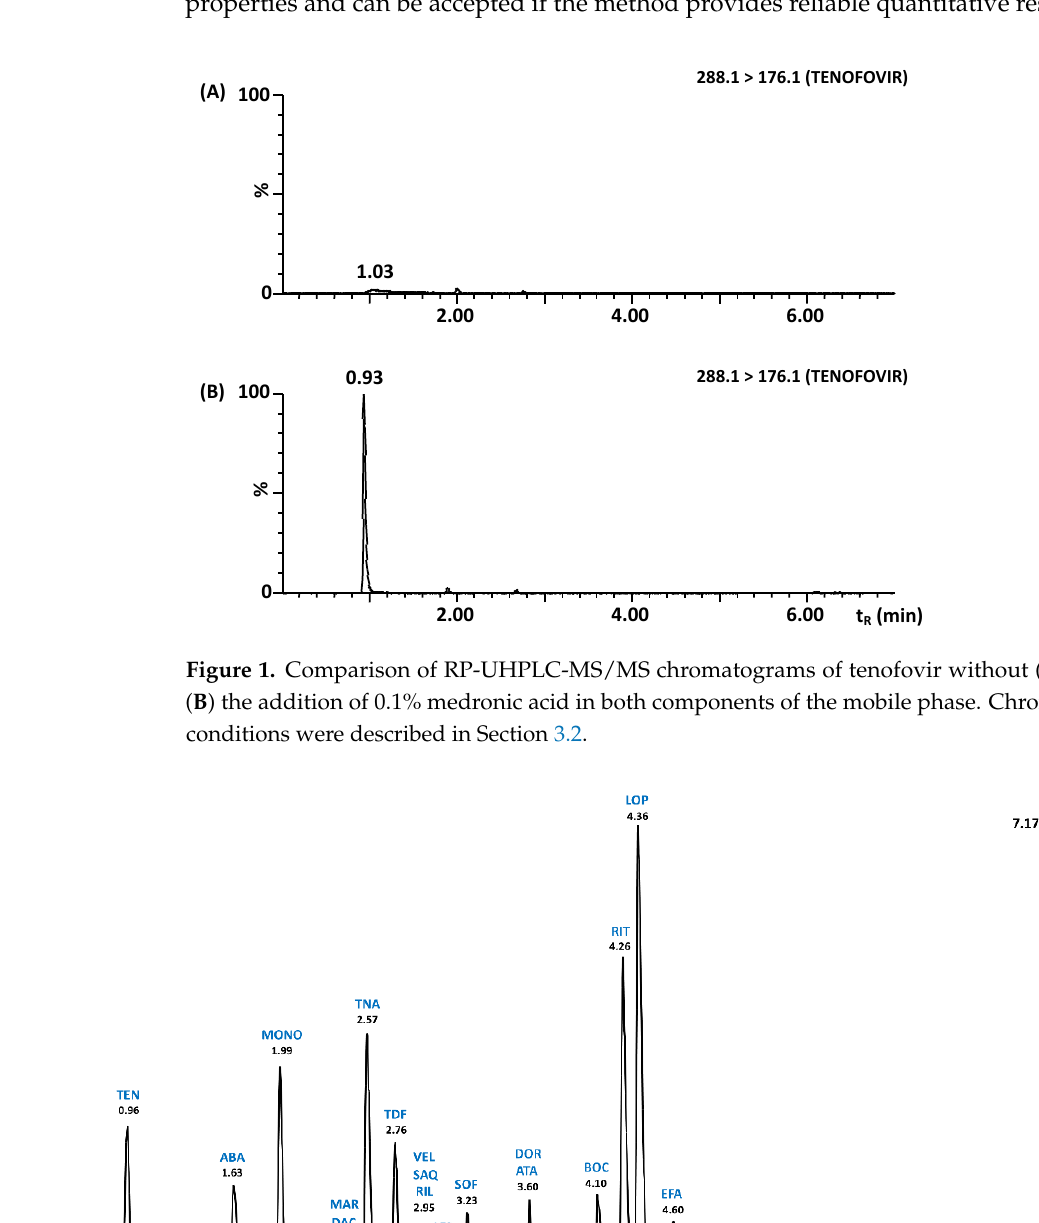
Figure 1. Comparison of RP-UHPLC-MS/MS chromatograms of tenofovir without ( A ) and with ( B ) the addition of 0.1% medronic acid in both components of the mobile phase. Chromatographic conditions were described in Section 3.2.